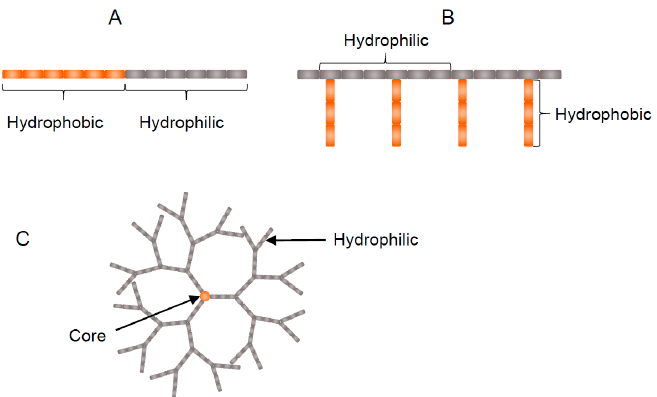
Figure 4. Schematic representation of amphiphilic polymer architectures: ( A ) Block copolymer; ( B ) Graft polymer and ( C ) Dendrimer.